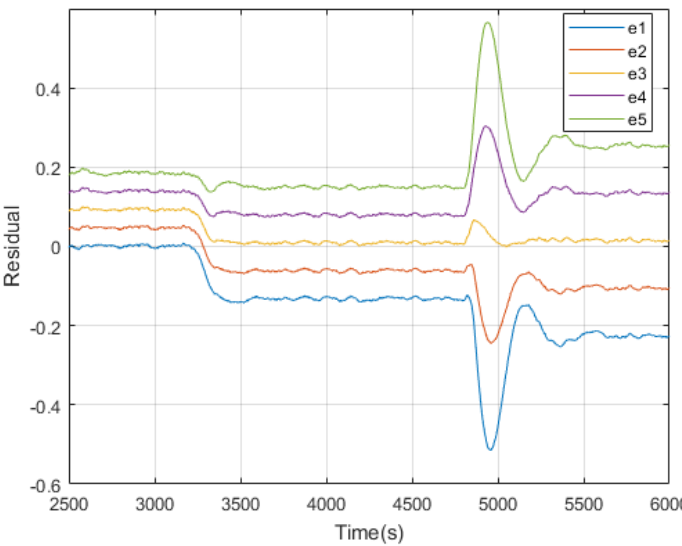
Figure 13. The simulation of interval residuals of T uin fault.